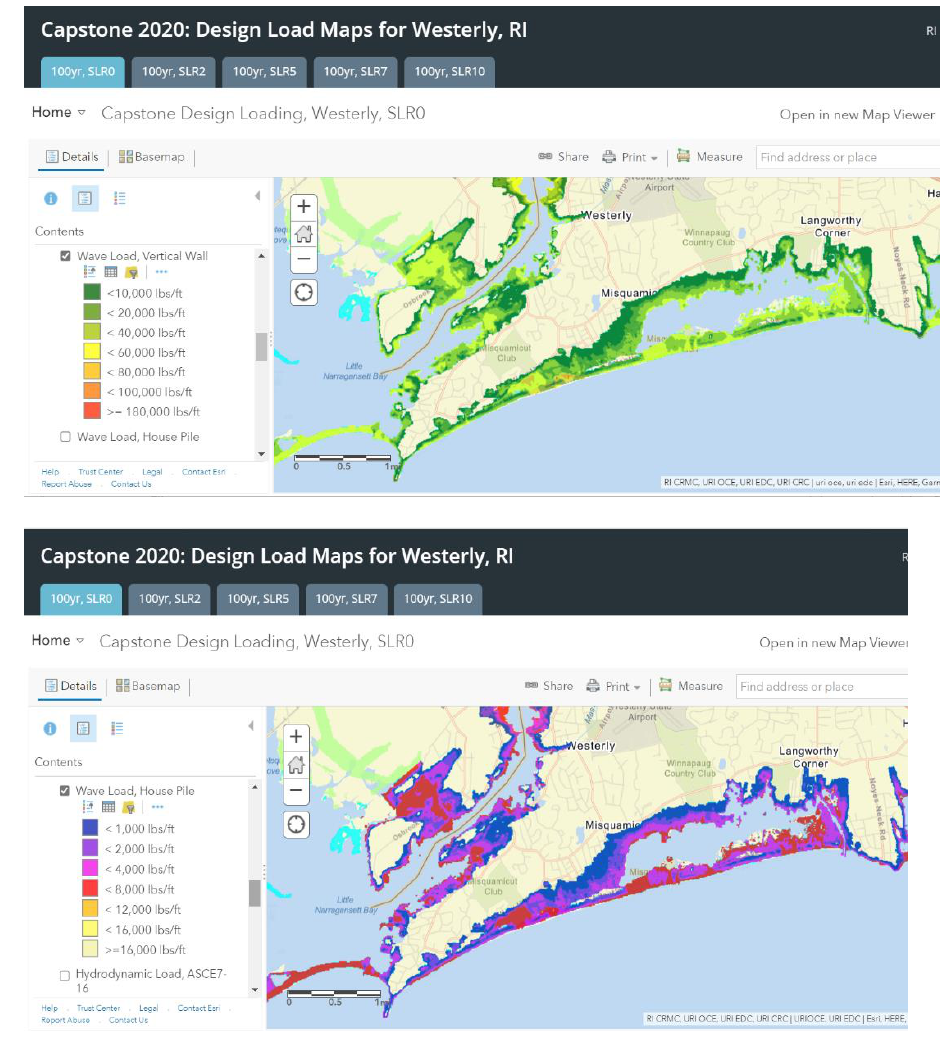
Figure 8. Wave load (lbs/ft) for vertical wall ( upper panel) and pile ( lower panel) house, 100 yr storm, 0 ft sea level rise (SLR).